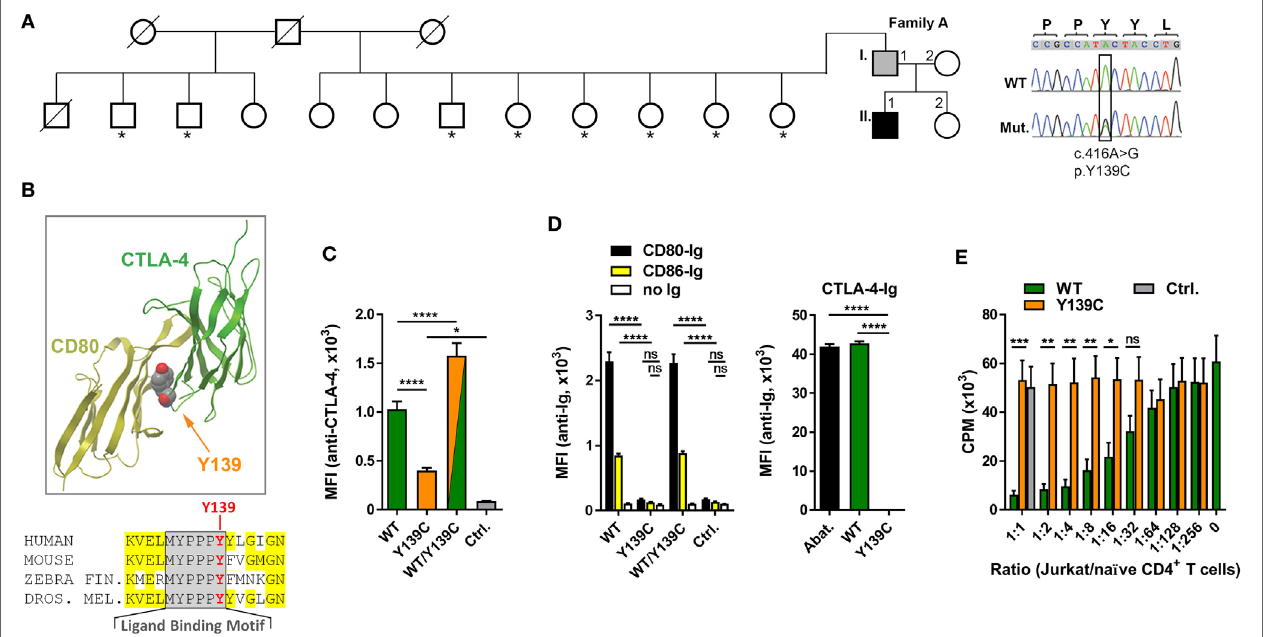
FigUre 1 | A novel mutation in cytotoxic T lymphocyte antigen-4 (CTLA-4) ligand binding motif. (a) Pedigree of family A, and Sanger sequencing of the mutation. Squares: male subjects; circles: female subjects; black filled symbol: patient with CTLA4 mutation; gray filled symbol: CTLA4 mutation carrier; crossed-out symbols: deceased subjects. CTLA4 was sequenced in all individuals of whom genomic DNA was available (asterisks). The position of the missense mutation (Mut.) in the cDNA (c.416A > G) is boxed and the resulting amino acid change p.Y139C is shown. WT, wild type. (b) Residue Y139 is highly conserved in the CTLA-4 MYPPPY binding motif as shown by the sequence comparison. Structure of CTLA-4 (green ribbon, right) and interaction-site of Y139 with CD80 (yellow ribbon, left). Position of Y139 is shown as space-filling model. (c) Mean fluorescence intensities (MFI) of CTLA-4 signals from Jurkat T cells expressing wild-type (WT, green bar), or mutant (Y139C, orange bar), or both forms (WT/Y139C) of CTLA-4 stained with anti-CTLA-4 antibodies and analyzed by flow cytometry. The cells express CTLA-4 proteins fused at their C-terminus with YFP (WT) or CFP (Y139C); Ctrl.: non-transduced cells. (D) Left bar graph: MFI of Jurkat T cells expressing WT, or Y139C mutant, or both forms of CTLA-4 stained with recombinant CD80-Ig (black) or CD86-Ig (yellow) and analyzed by flow cytometry. Right bar graph: MFI of EBV cells expressing CD80 and CD86 stained with abatacept (Abat., black), wild type (WT, green), or mutant CTLA-4-Ig and analyzed by flow cytometry. (e) In vitro proliferation assay with naïve CD4 T cells activated with anti-CD3 in presence of heterologous EBV cells. T cell proliferation was inhibited by adding increasing numbers of Jurkat T cells expressing WT CTLA-4 (WT, orange bars) but not by cells expressing Y139C mutant CTLA-4 (green bars) (Ctrl.: Jurkat T cells). Data in (c,D) are from three experiments done in triplicates and in (e) from three experiments with five different healthy donors shown as mean ± SEM. **** P ≤